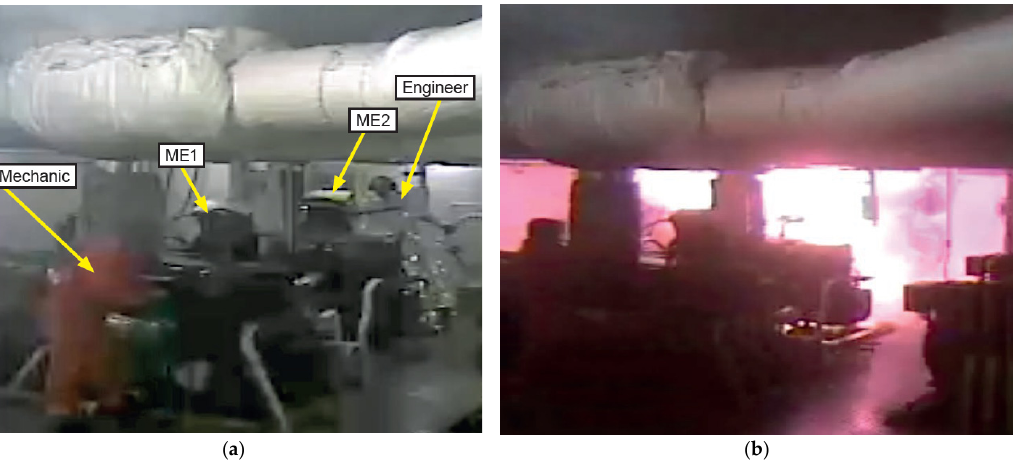
Figure 4. CCTV footage showing the explosion of a high-speed trunk piston engine: ( a ) just before the accident; ( b ) at the time of the accident (adapted from [51]).